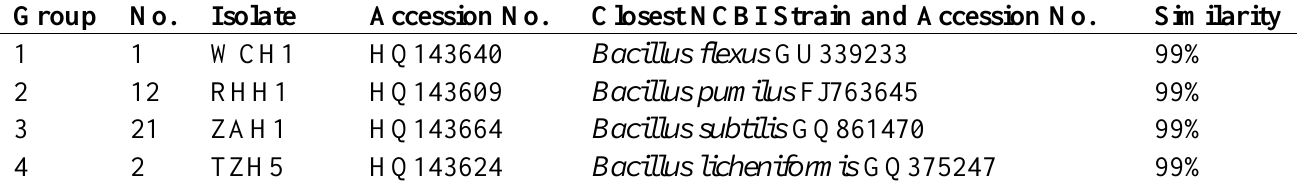
Table 1. List of antagonistic bacteria obtained in this study representing each 16S-RFLP group and their closest affiliation according to sequencing of 16S rRNA